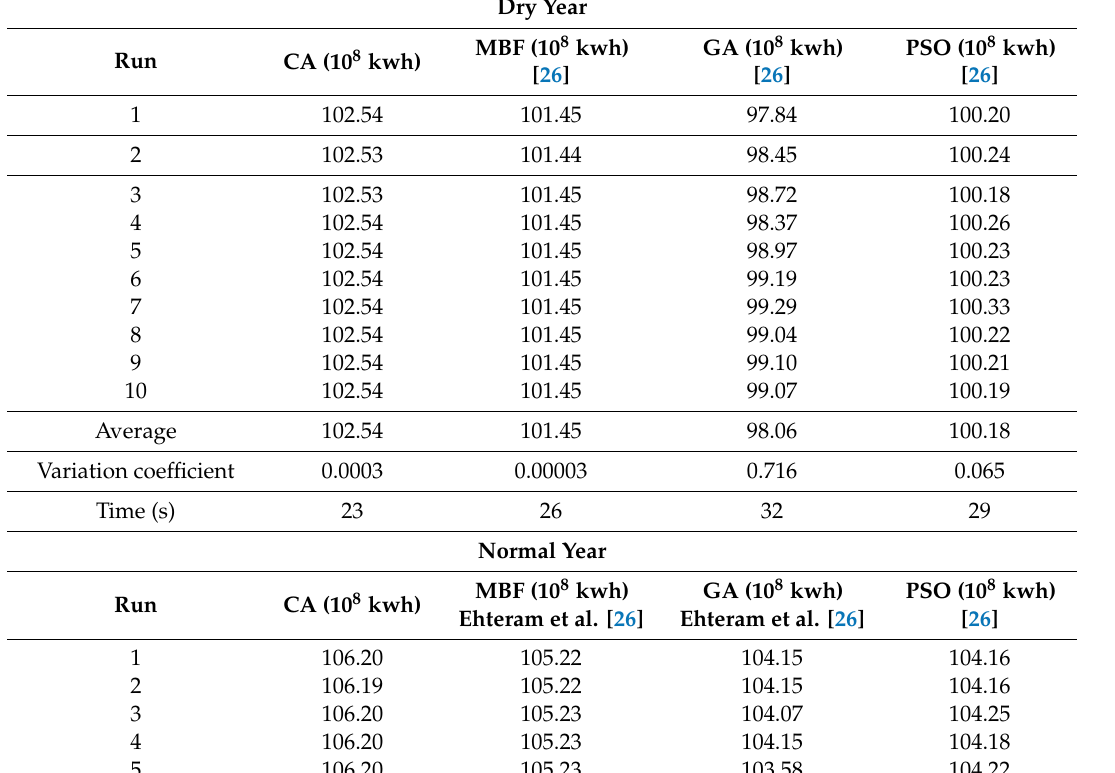
Table 4. Power production for dry years, normal years, and wet years. CA: Crow algorithm; MBF: Monarch butterfly; GA: Genetic algorithm; PSO: Particle swarm